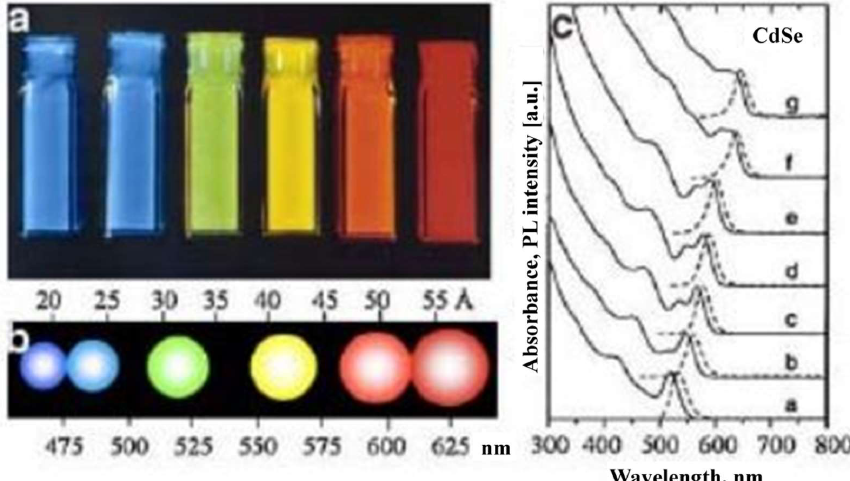
Figure 11. Size-dependent absorption and emission spectra of CdSe semiconductor nanocrystals with various sizes. ( a ) Size-dependent luminescence color and ( b ) schematic presentation of size, color, and emission wavelength of CdSe–ZnS QDs. ( c ) Absorption (solid lines) and emission (broken lines) spectra of CdSe QDs with various sizes